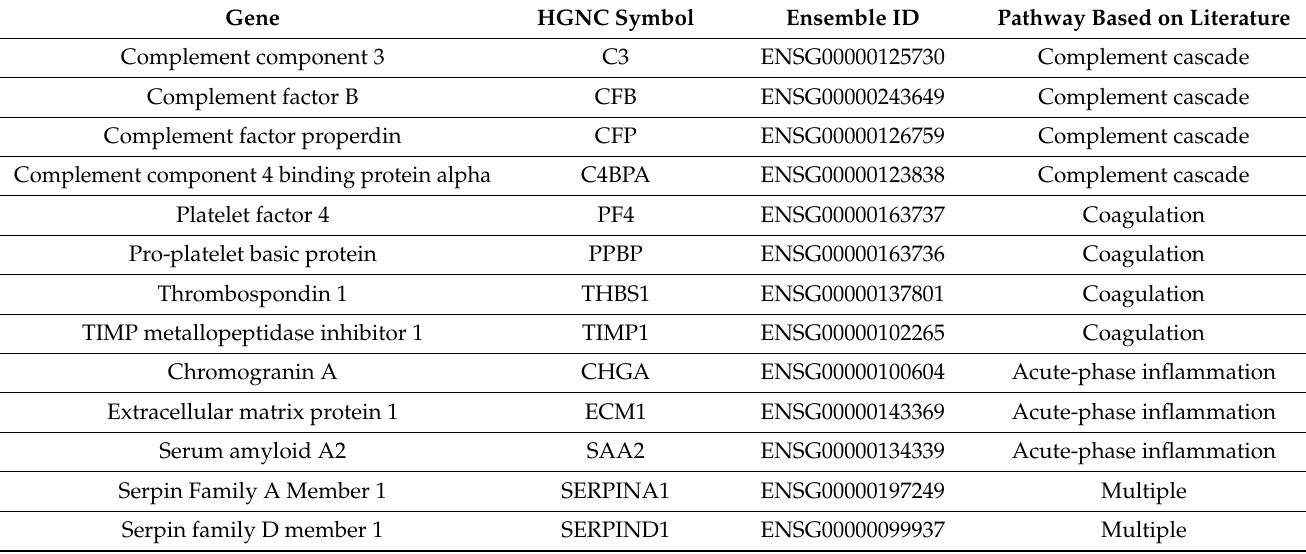
Table 1. Functional annotations of the 13 stroma-derived genes from the Stromal Liquid Biopsy panel. Gene HGNC Symbol Ensemble